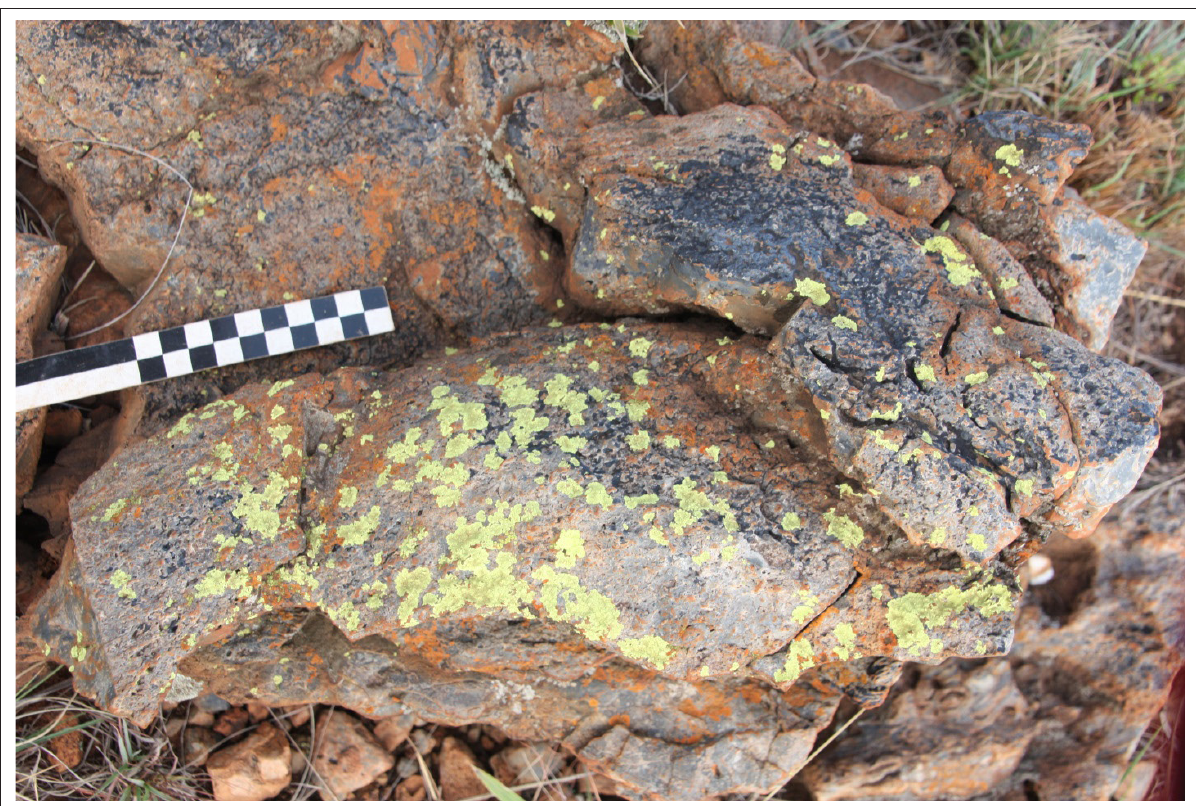
Figure 3: A chert rock at Kromdraai, showing black manganese oxy-hydroxide in association with green lichen. The manganese oxy-hydroxide may relate to earlier episodes of lichen growth on the same rock. Scale: centimetre squares are shown in black and white. Photograph: Benjamin Lans.